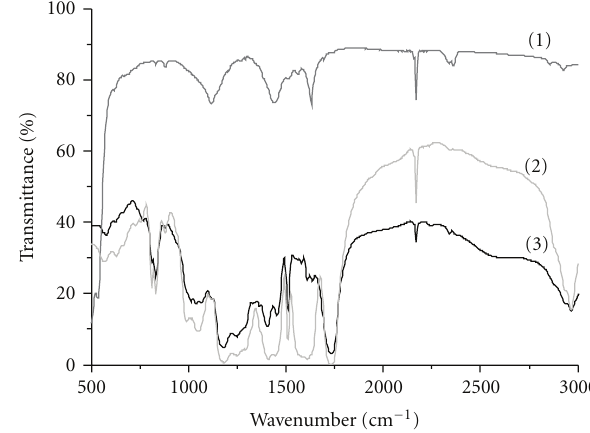
Figure 4: FTIR spectra: nanoparticles ZnO (1), composition 2Carb/BisA (70/30) + 12wt.% ZnO (2), and pure 2Carb/BisA (70/30)